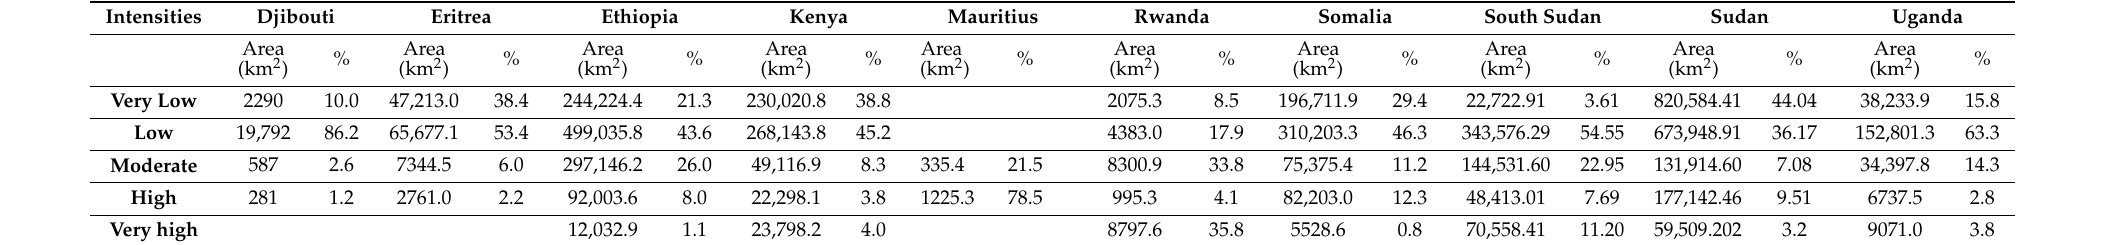
Table 13. Soil Productivity Index for the studied